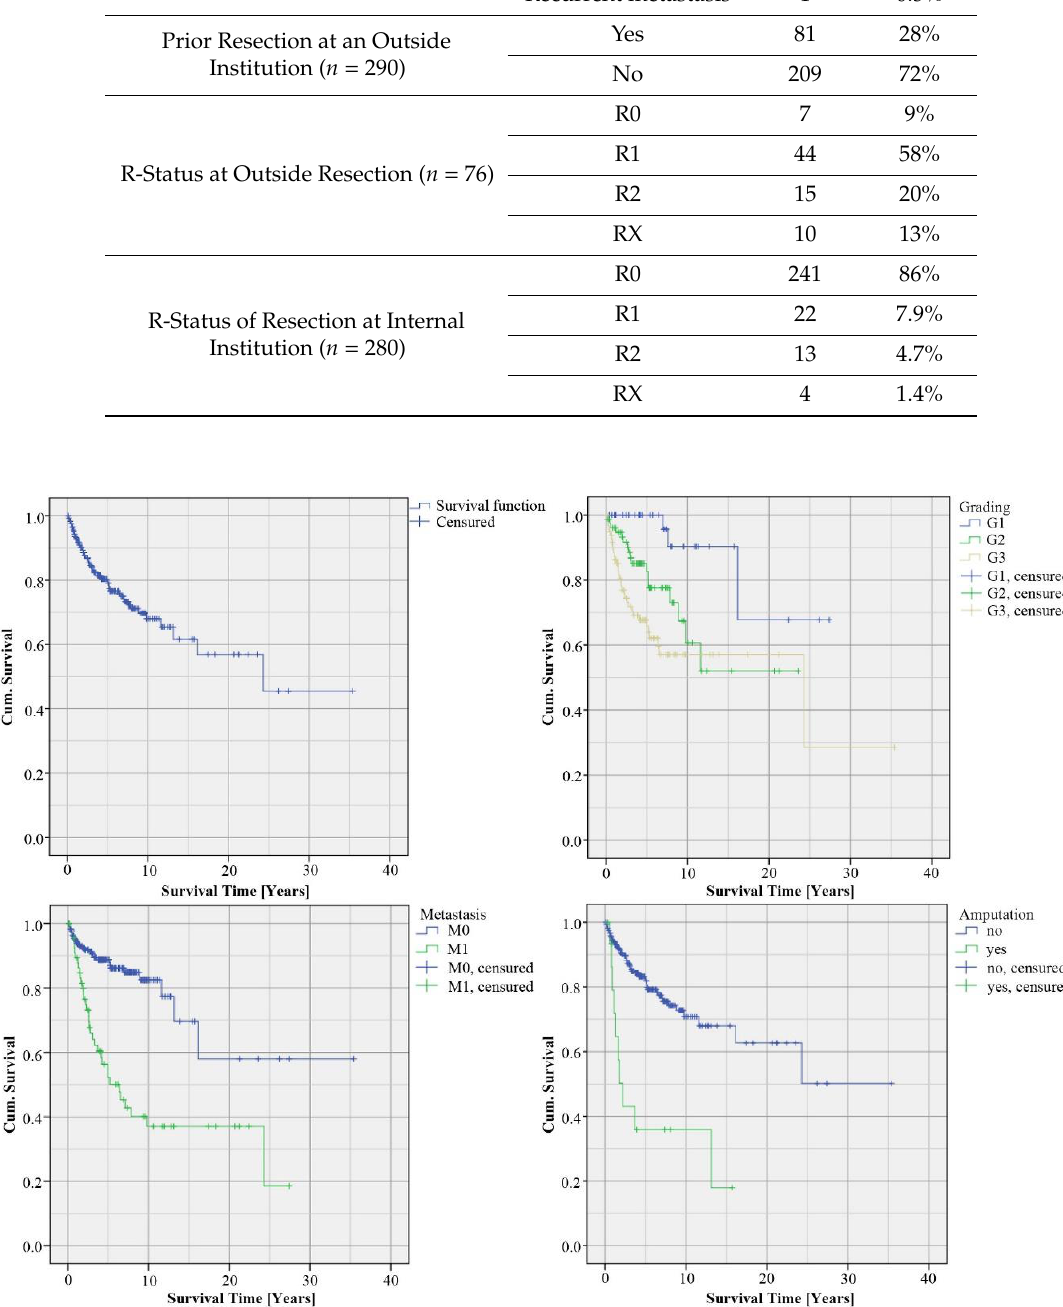
Figure 1. Kaplan–Meier curves of cumulative survival.